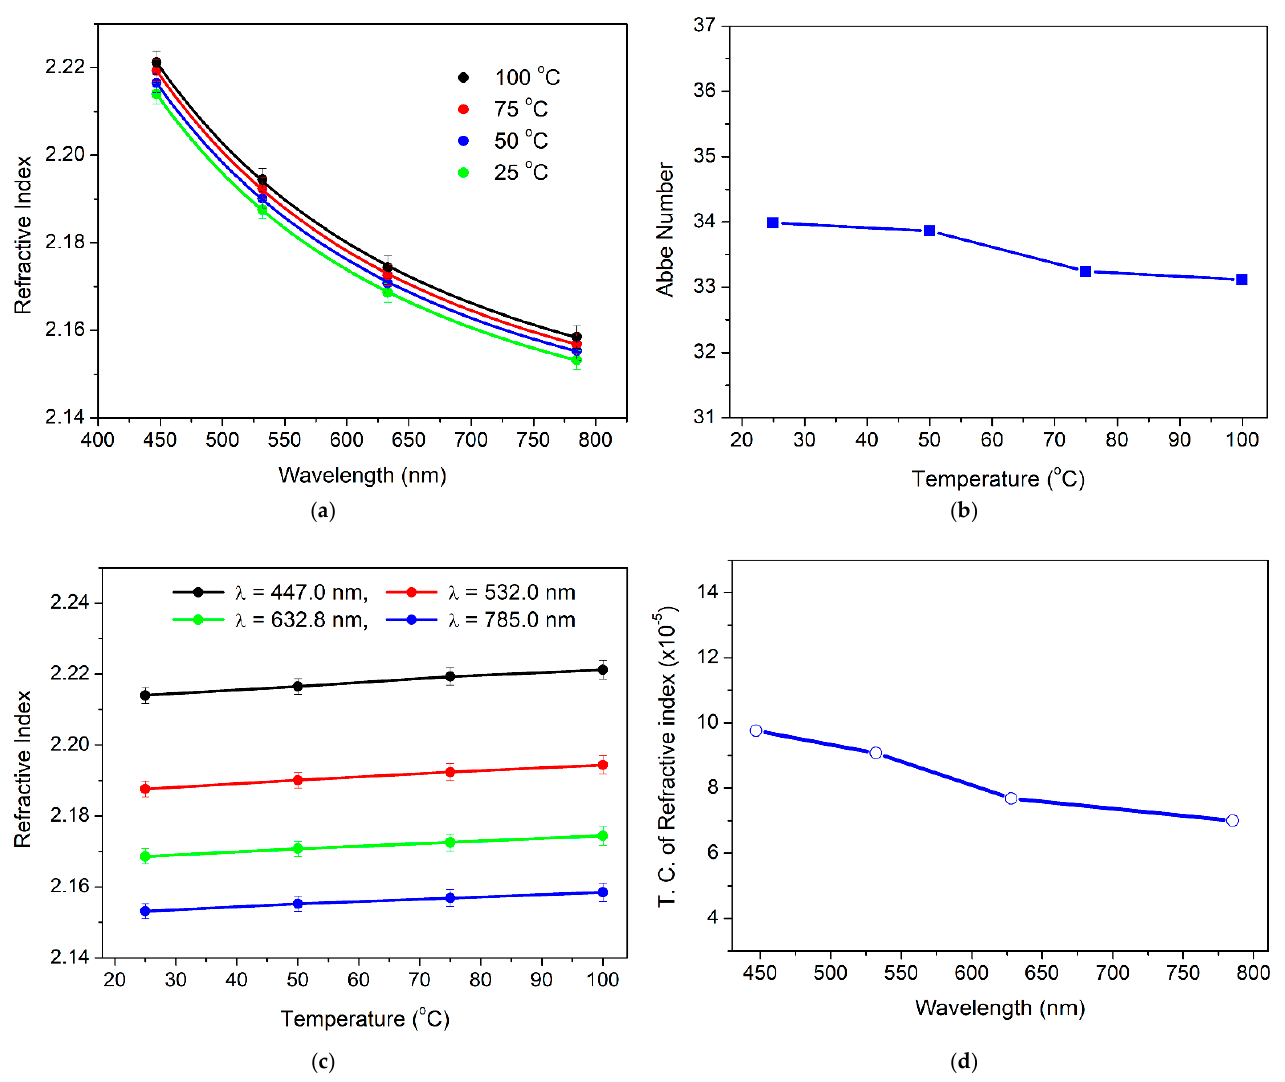
Figure 3. ( a ) Dispersion in the visible and NIR wavelengths of the fabricated CZ sample depending on temperature; ( b ) Abbe number ( ν d ) estimated from the average refractive indices in ( a ) as a function of temperature; ( c ) temperature dependence of the refractive indices at 447 nm, 532 nm, 632.8 nm and 785 nm for the CZ sample; ( d ) temperature coefficient of refractive index estimated from the average refractive indices in ( c ) depending on the wavelength.